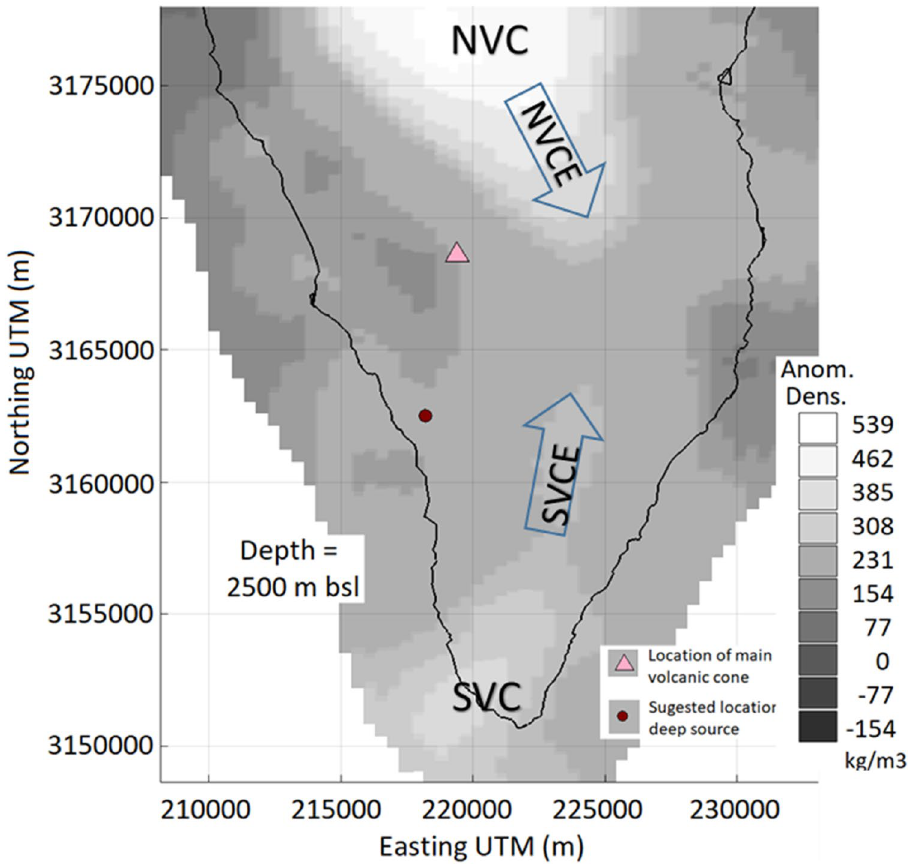
Figure 3. Horizontal slice of the obtained 3D crustal density model for La Palma. Horizontal section of the 3D model for anomalous density for La Palma Island at 2500 m depth below sea level (bsl). Suggested location of deep source is an approximation to the location of the input of magma from deeper zones, from our geodetic modeling. Matlab software (www. mathw orks. com) and Microsoft PowerPoint 2016 were used to create this